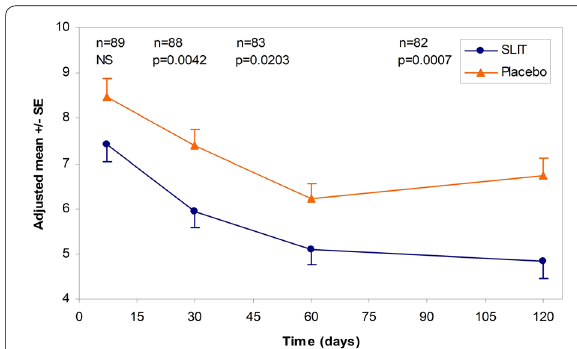
Fig. 1 Average RTSS at each challenge during the treatment period (after 1 week, 1 month, 2 months and 4 months of treatment): the means were adjusted for the baseline covariate reproduced from [42] with kind permission from